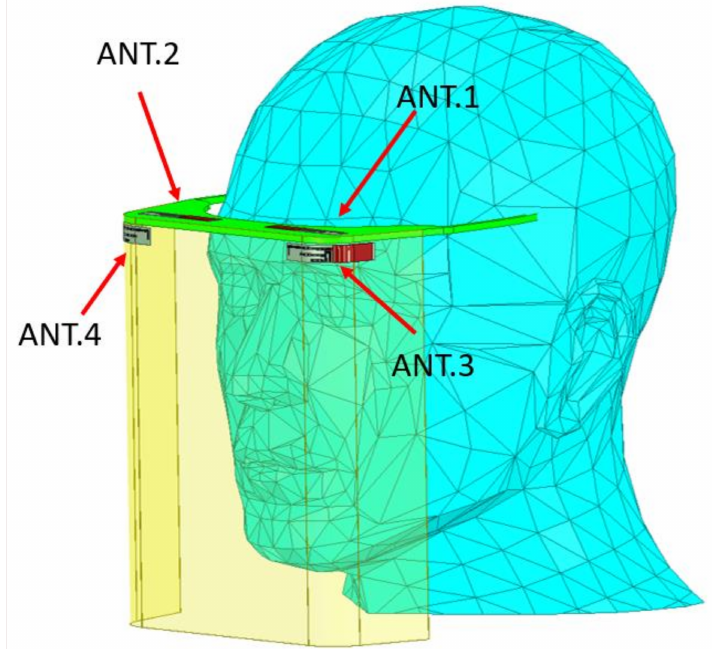
Figure 27. Medical mask with antenna system worn on human head